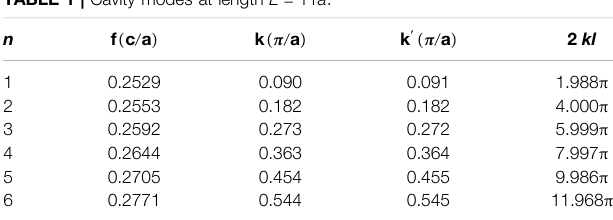
TABLE 1 | Cavity modes at length L (cid:1) 11 a